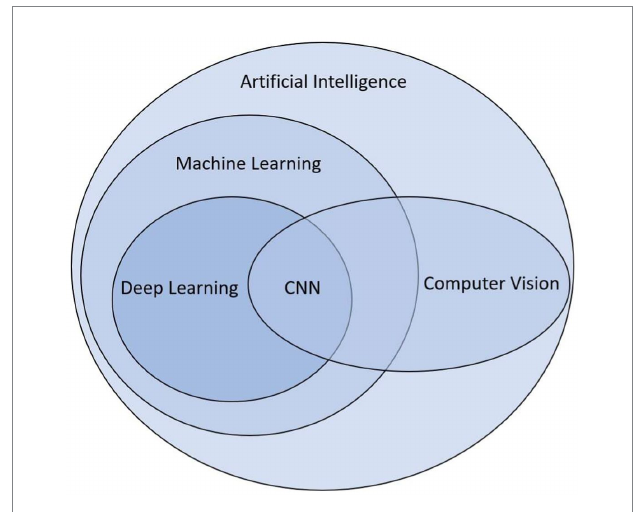
FIGURE 1 Euler diagram of artificial intelligence and neural networks in computer